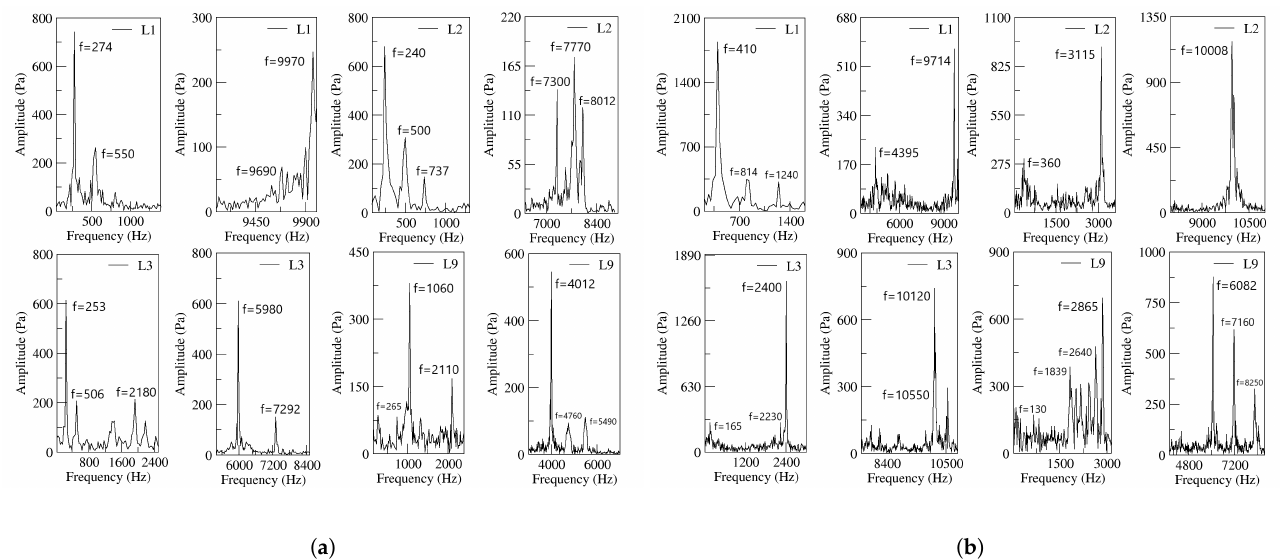
Figure 13. Frequencies obtained from the stagnation pressure measured at the MC inclined walls, all feedback channels lengths are evaluated. ( a ) Power nozzle velocity, 65 m/s. ( b ) Power nozzle velocity, 97 m/s.